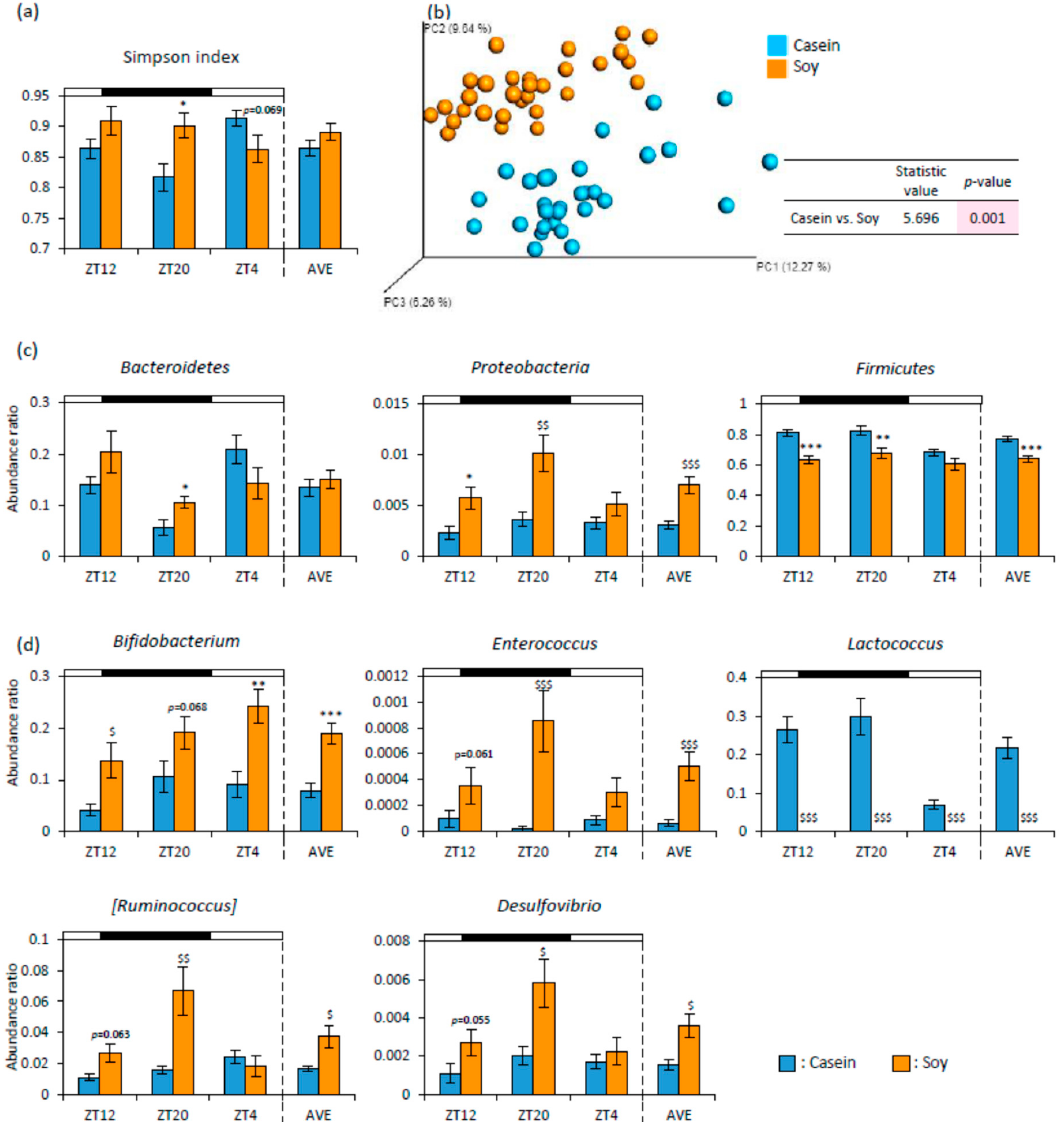
Figure 4. The effect of soy protein intake on microbiota. ( a ) Alpha-diversity about Simpson index (ZT12, ZT20, ZT4, and an average of three points) of mice that were fed each diet for 10 days. ( b ) Beta-diversity in comparison of each diet. The PCoA plots of unweighted UniFrac distance metrics obtained from sequencing the 16S rRNA gene in feces ( n = 30). ( c ) The relative abundance of microbes at the Phylum level, and ( d ) at the Genus level of mice that were fed each diet for 10 days (ZT12, ZT20, ZT4, and an average of three points). Data ( a , c , d ) are represented as mean ± SEM ( n = 10). * p < 0.05, ** p < 0.01, *** p < 0.001 versus Casein, evaluated using Student’s t -test. $ p < 0.05, $$ p < 0.01, $$$ p < 0.001 versus Casein, evaluated using the Mann-Whitney test. The table in ( b ) indicates the result using PERMANOVA.